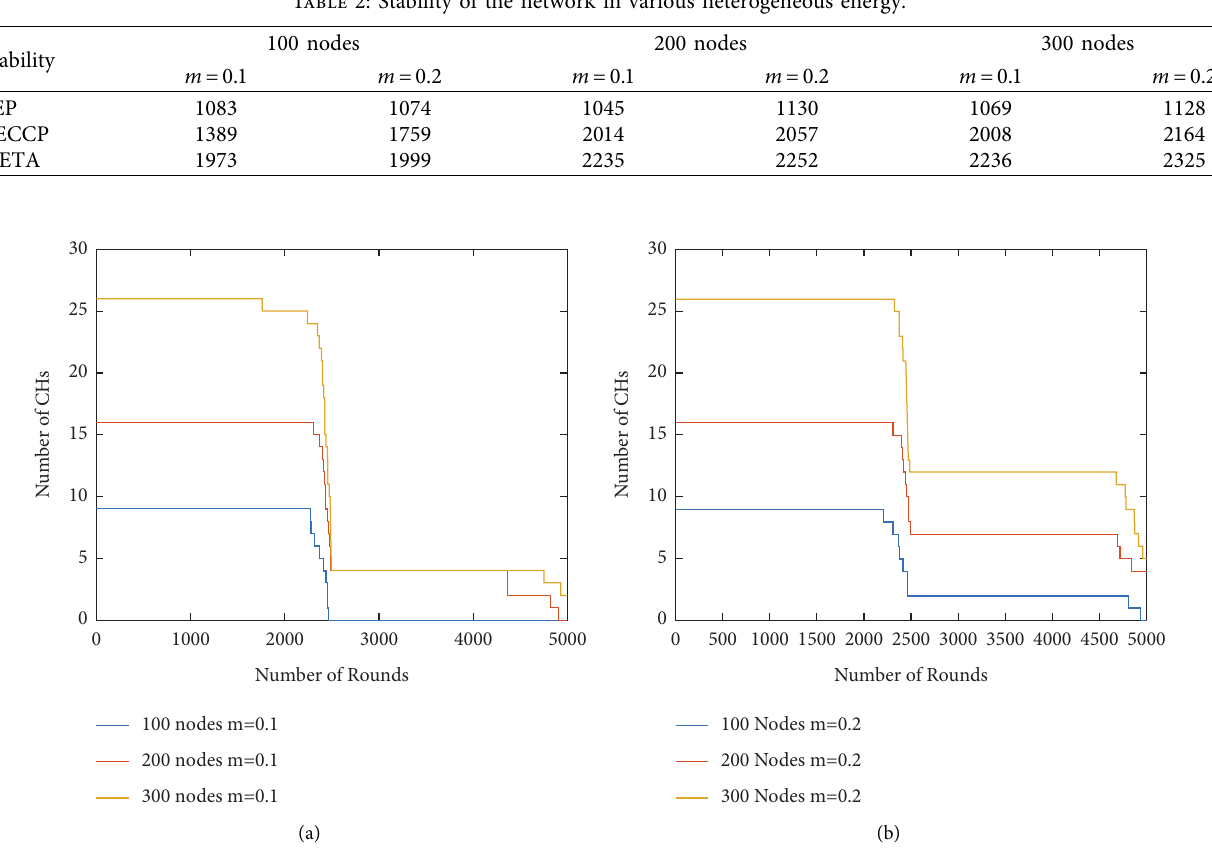
Figure 4: The static CH allocation in different nodes. (a) 10% of heterogeneous energy; (b) 20% of heterogeneous energy.